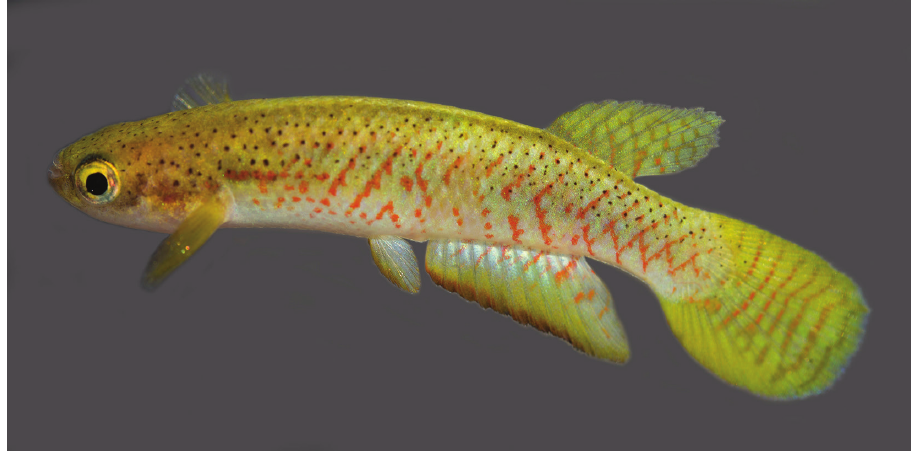
Figure 4. Melanorivulus flavipinnis sp. n., holotype, UFRJ 6881, male, 28.5 mm SL. Photograph by W.J.E.M.